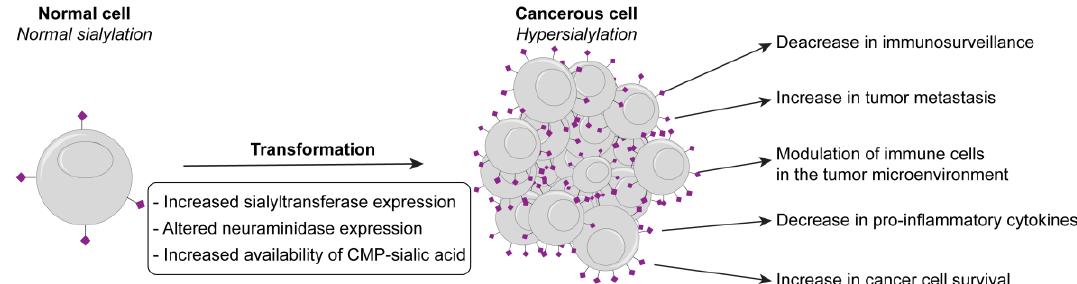
Figure 1. Hypersialylation in cancer: causes and effects. Elevated levels of sialic acid on transformed cells can be driven by at least three different mechanisms. Hypersialylation on cancer cells can promote tumor development and survival in a many of different ways but one key mechanism is through modulating immune cell responses and in particular those immune cells types involved in modulating the inflammatory environment in tumors.